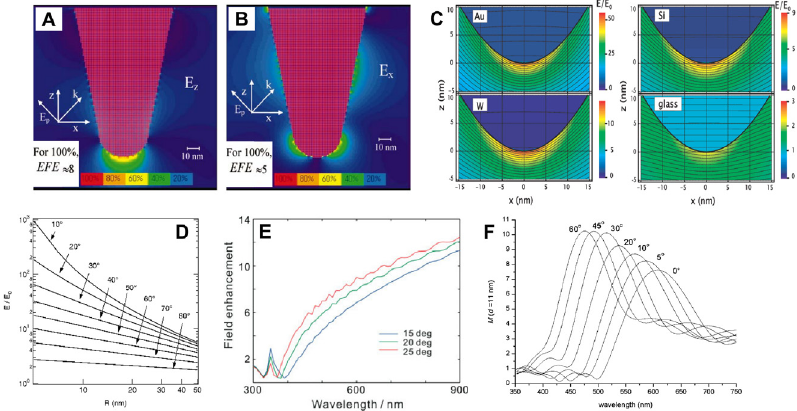
Figure 2: (A – B) Simulated E z and E x fi eld distributions of Au tip illuminated by p - polarized light [71]. Copyright 2004 Optical Society of America. (C) Simulated electric fi elddistributionof free-standingtipsmade with various materials, such as Au, W,